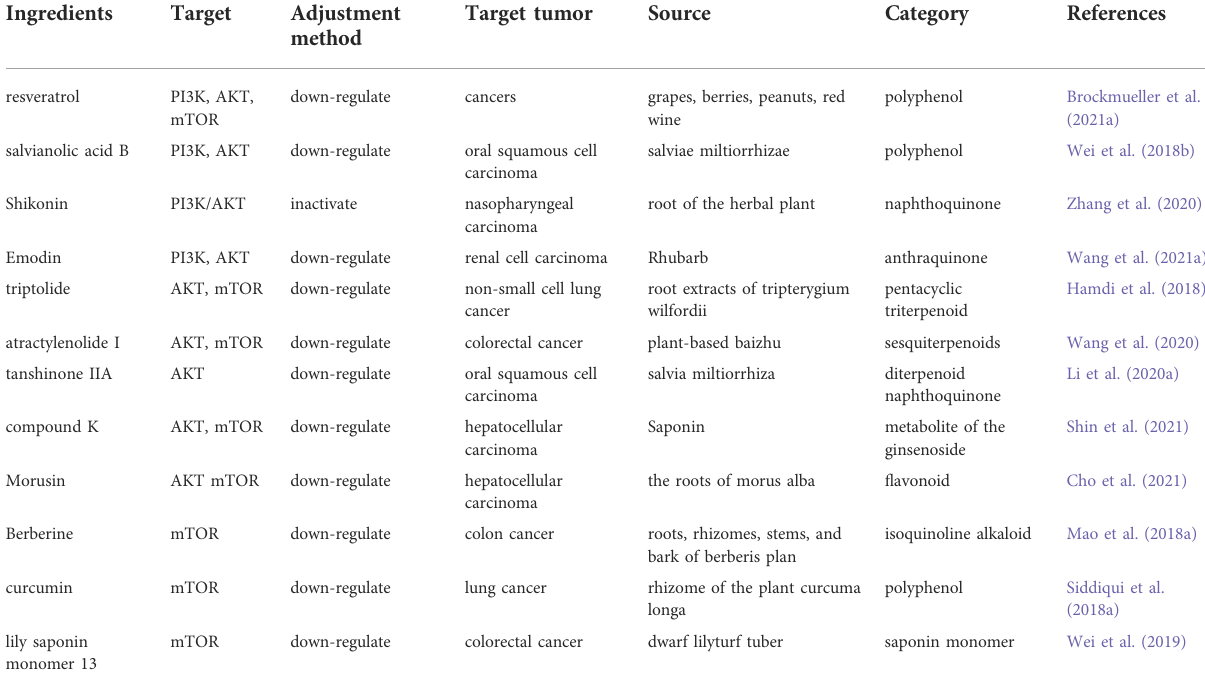
TABLE 2 Natural products regulate glycolysis through the PI3K-AKT-mTOR signaling pathway in cancer. Ingredients